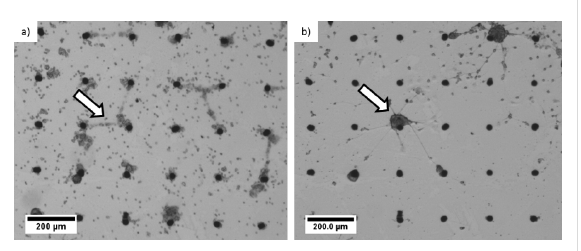
Figure 3: Growth of cortical neurons cultured on islands of vertically aligned CNT architectures. a) Formation of neuron clusters after 4